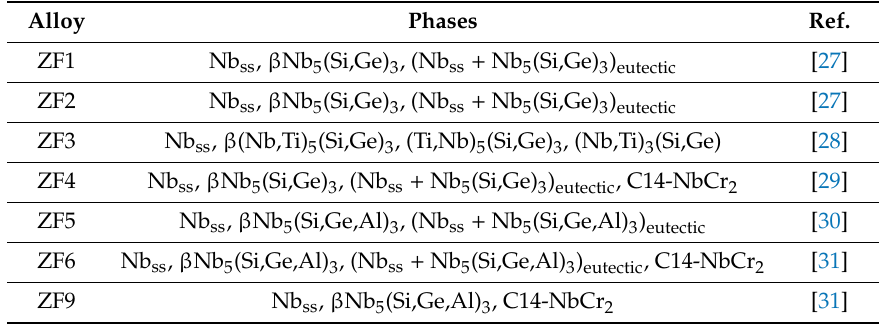
Table 1. Phases in the microstructures of the as-cast alloys of this study. Alloy